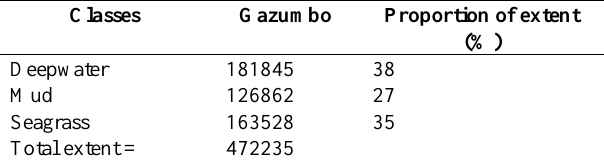
Table 2. Summary of seagrass locations using MLC.